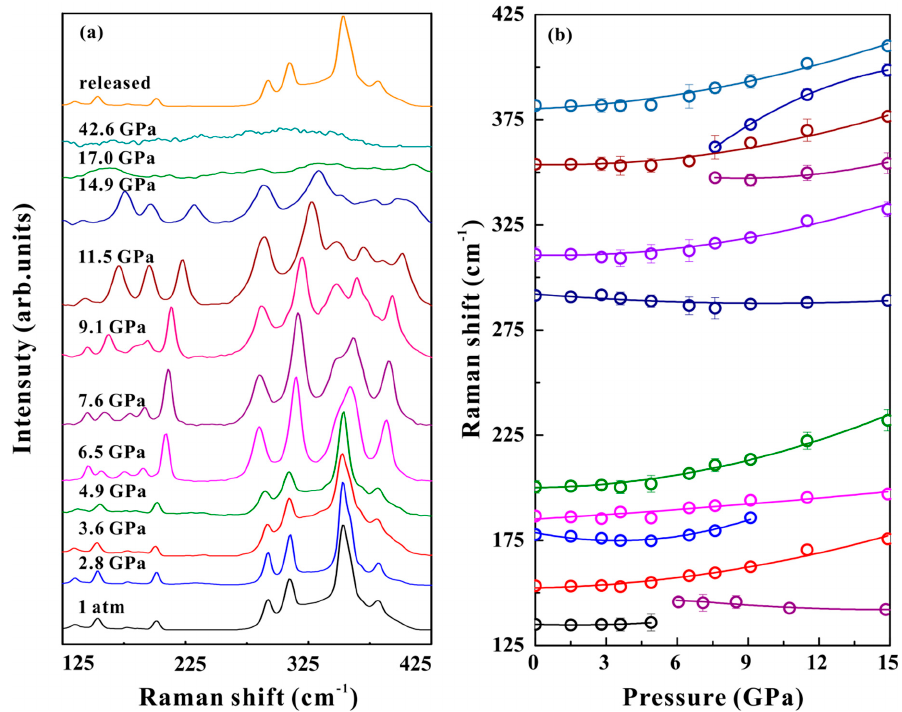
Figure 3. ( a ) Raman spectra of orpiment at selected pressures under non-hydrostatic condition ( λ = 514 nm, T = 300 K). ( b ) Raman shift of orpiment with increasing pressure.